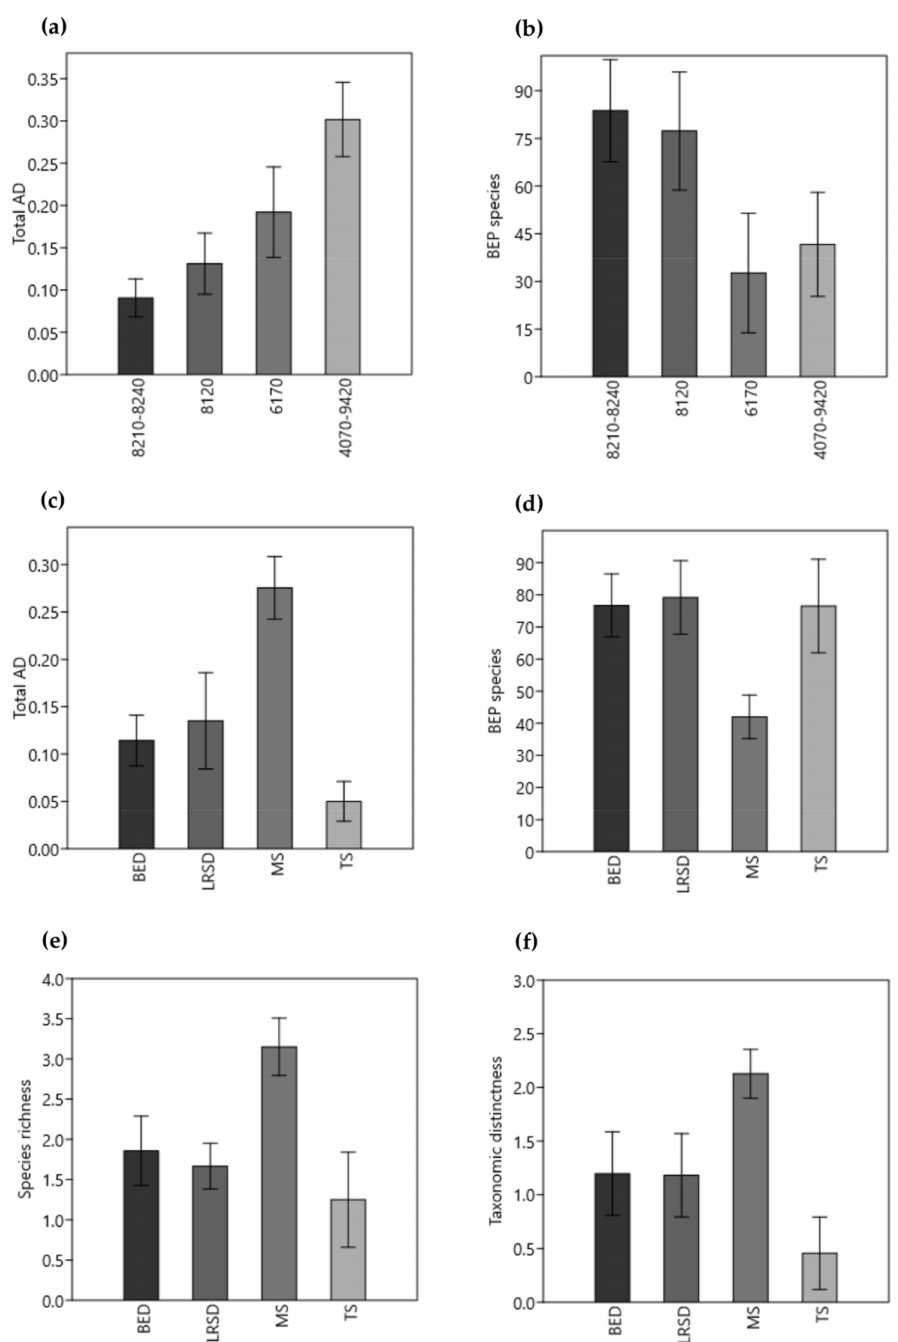
Figure 2. Average carabid species richness, taxonomic distinctness, total activity density and frequency of BEP species ( y -axis) in relation to the Nature 2000 habitat (6170 = alpine and sub- alpine calcareous grasslands; 8120 = calcareous and calcshist screes of the montane to alpine lev- els; 8210-8240 = limestone pavements and calcareous rocky slopes with chasmophytic vegetation; 9420-4070 = alpine Larix decidua and/or Pinus cembra forests and bushes with Pinus mugo and Rhodo- dendron hirsutum ); graphs ( a , b ) and landform types (BED = bedrock; LRSD = large rockslide deposit; MS = mature slope; TS = talus slope); graphs ( c – f ). The whisker intervals represent a 95% confidence interval based on the standard error. Only the results in which we obtained a significant difference ( p < 0.05) among habitat and landform type are represented (for more information see Table